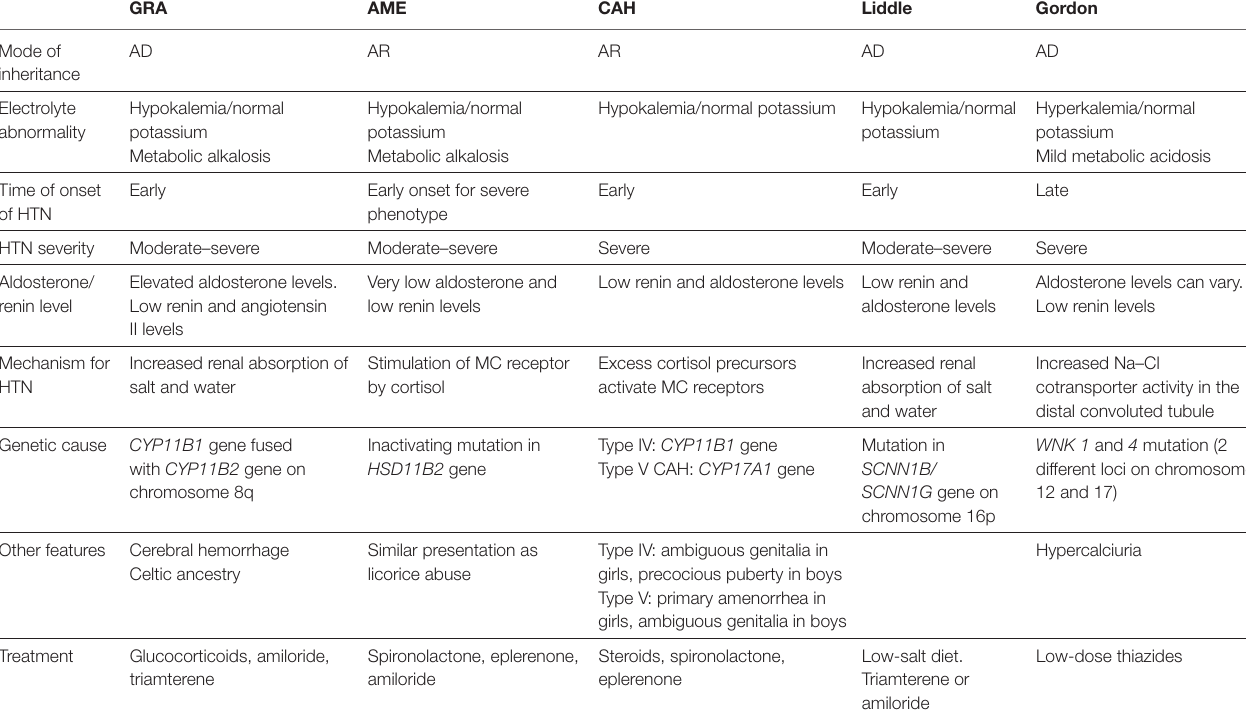
Table 1 | Summary of the various forms of monogenic HTN. GRa